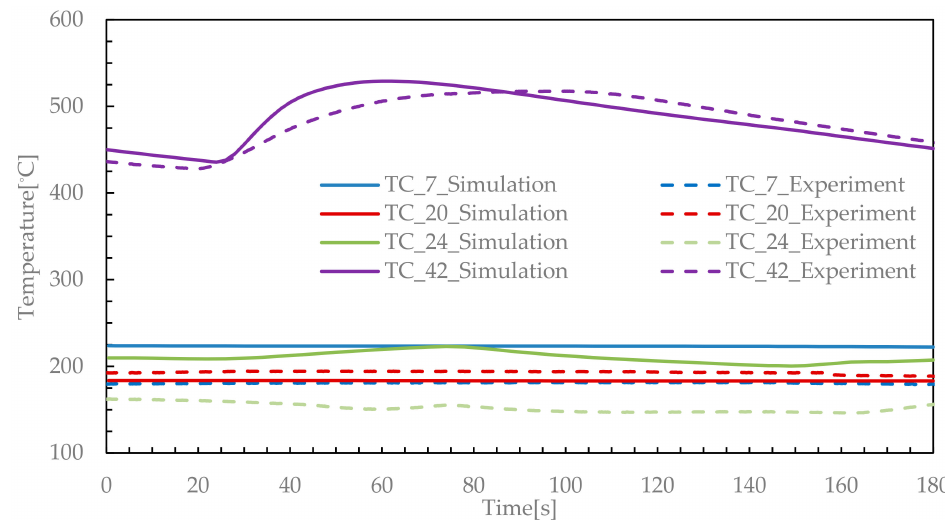
Figure 3. Comparison between the experimental data (dash) and simulated (solid) temperatures in the dies.